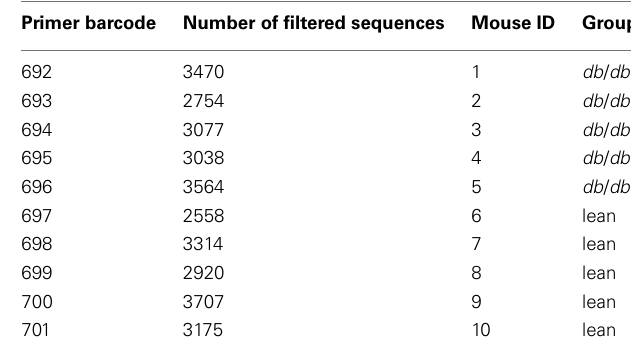
TABLEA1 | Sequencing statistics for 10 cecal